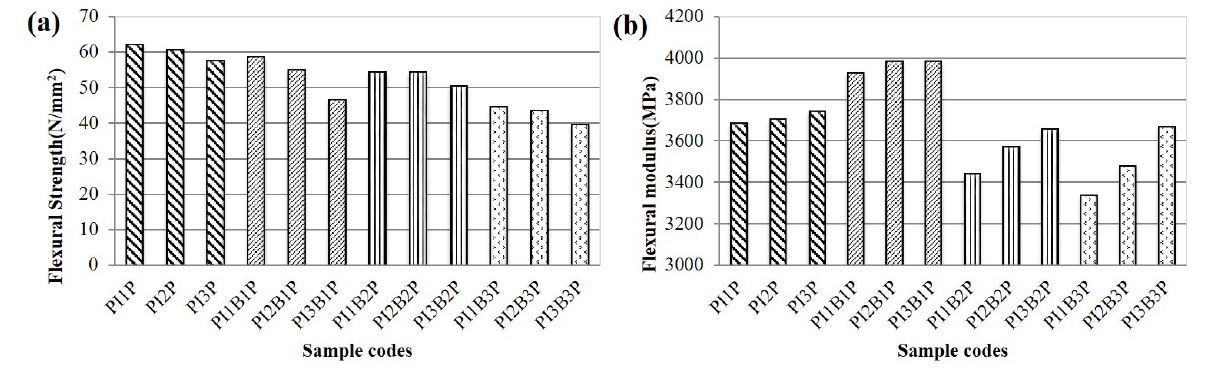
Figure 2: Bending properties of pine cone/boron polyester composite materials, a) flexural strength, b) flexural modulus.